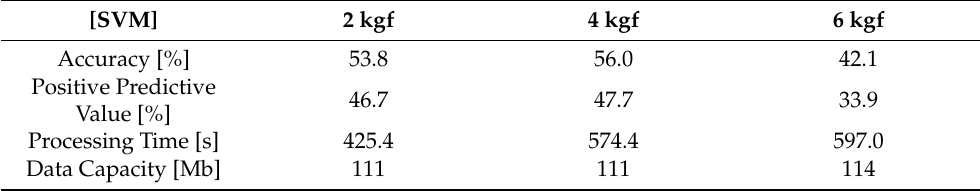
Table 12. Nip roll eccentricity fault diagnosis based on raw data (i.e., Sensors 1, 2, and 3). [SVM]